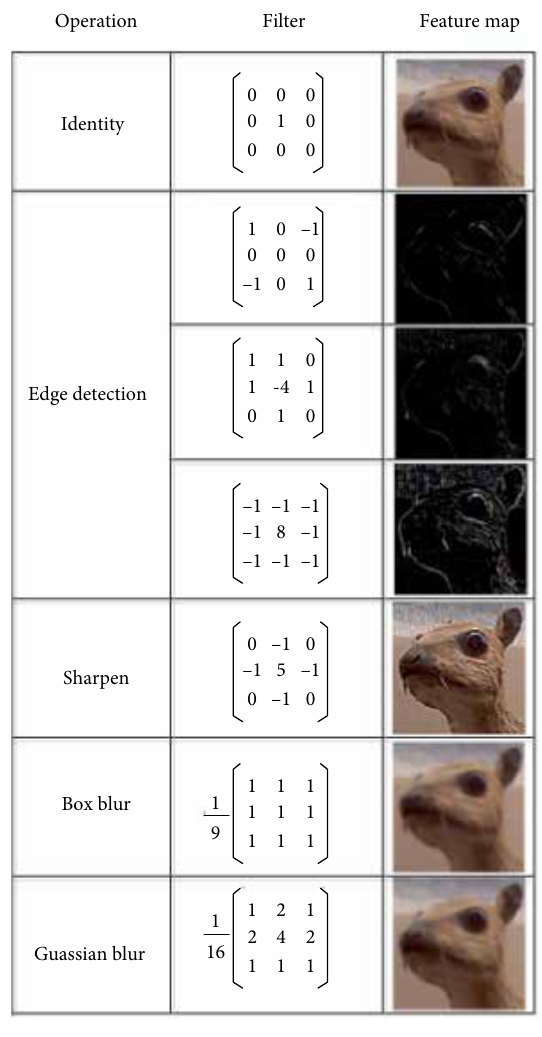
Figure 3: Convolution operation application in image feature exaction